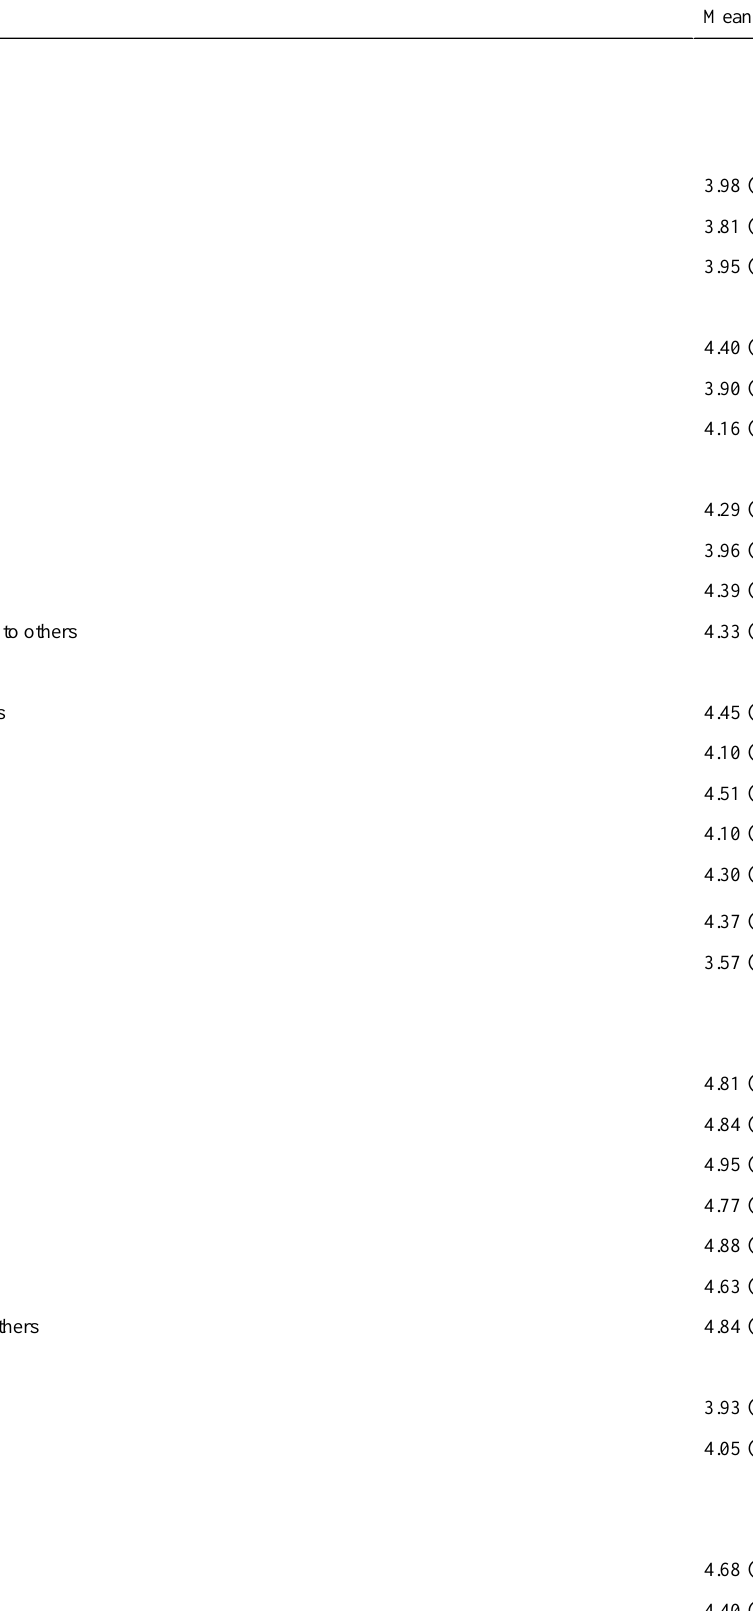
Table 4. Usability and perceived benefits of Children Eating Well smartphone app prototype features (note: response choices for each item ranged from 1=strongly disagree to 5=strongly agree. Interpretation: successful—4.0 and higher; needs improvement—3.0 to 3.99; needs major changes—below